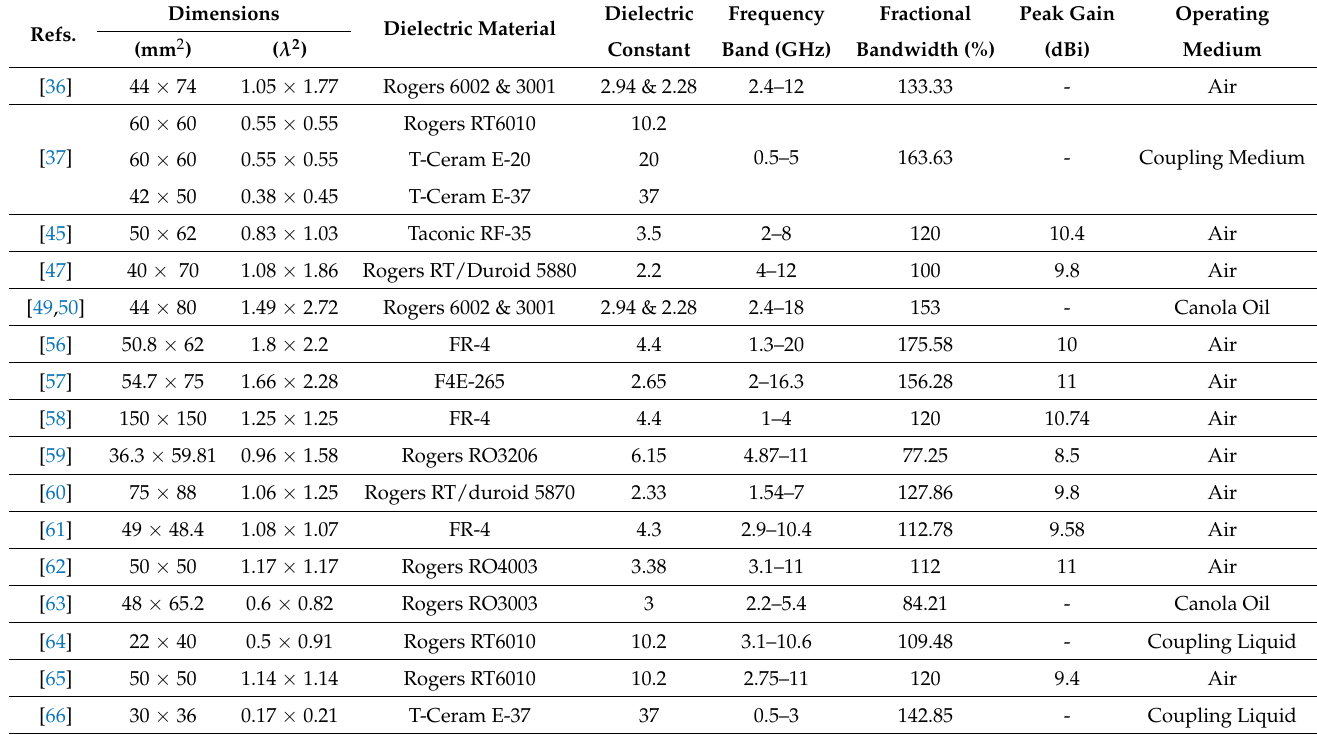
Table 2. Performance comparison among Vivaldi antennas designed for microwave imaging